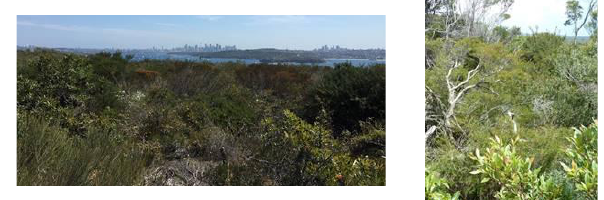
Figure 1. Heathland a) Exposed sites with heights of 1.2 m or less, b) Closed sites with heights in excess of 2 m and sparse